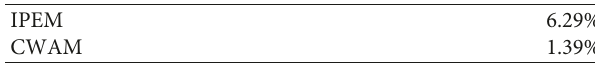
Table 13: Excitation 2’s relative errors of the root mean square